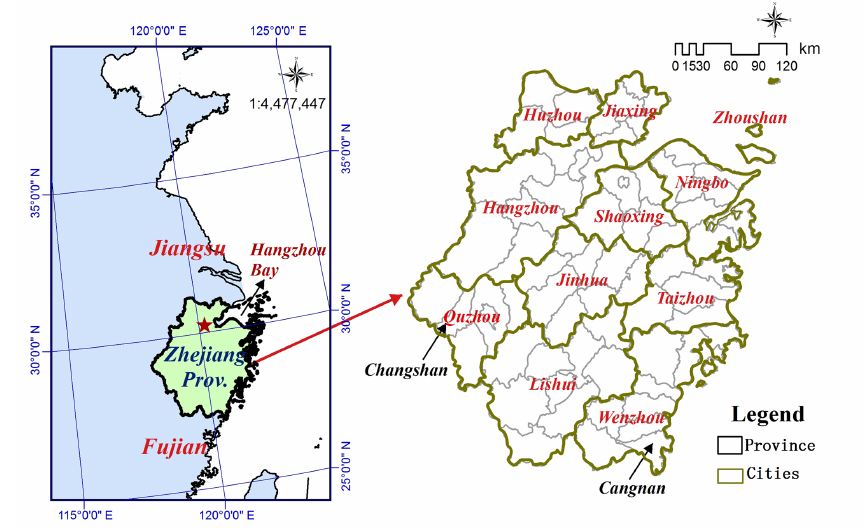
Figure 1. Maps of Zhejiang Province, China, showing location and major cities.